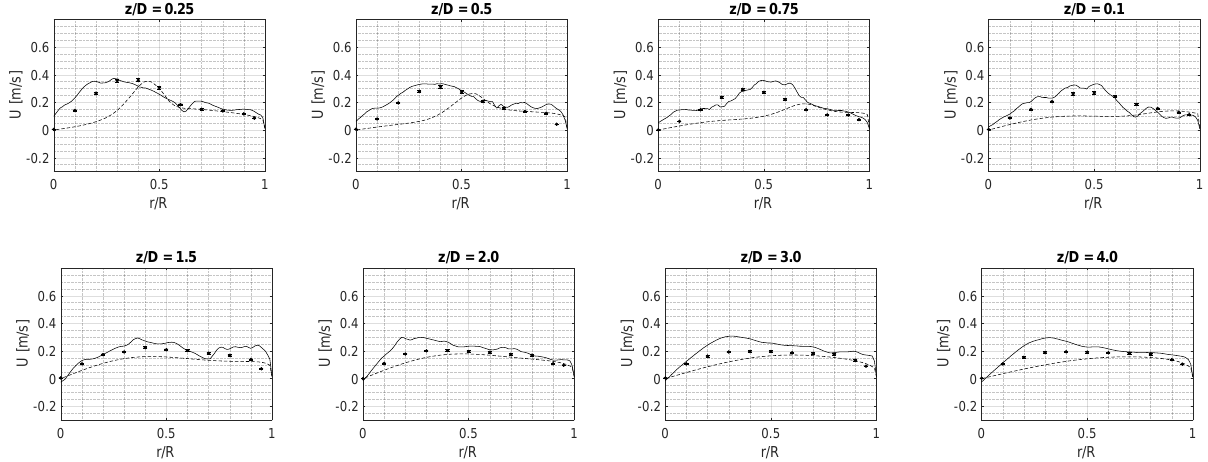
Figure 10: Mean tangential velocity at several cross sections (dashed line: k- ω SST RANS, solid line: WALE LES, dots: experiments)